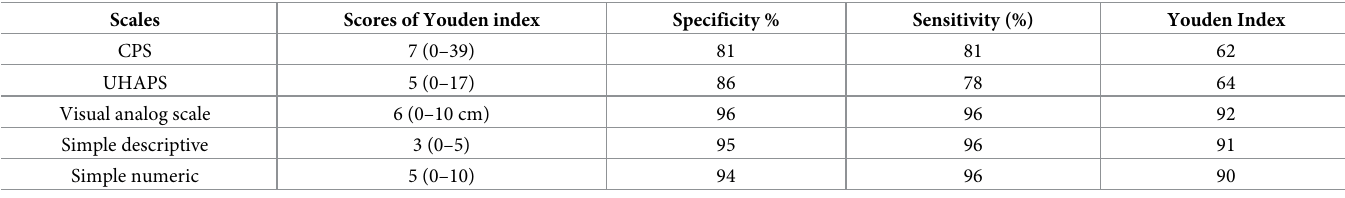
Table 10. Youden index based on highest sensitivity and specificity for the Unesp-Botucatu horse acute pain scale (UHAPS), the Composite Pain Scale (CPS), and unidimensional scales. Scales